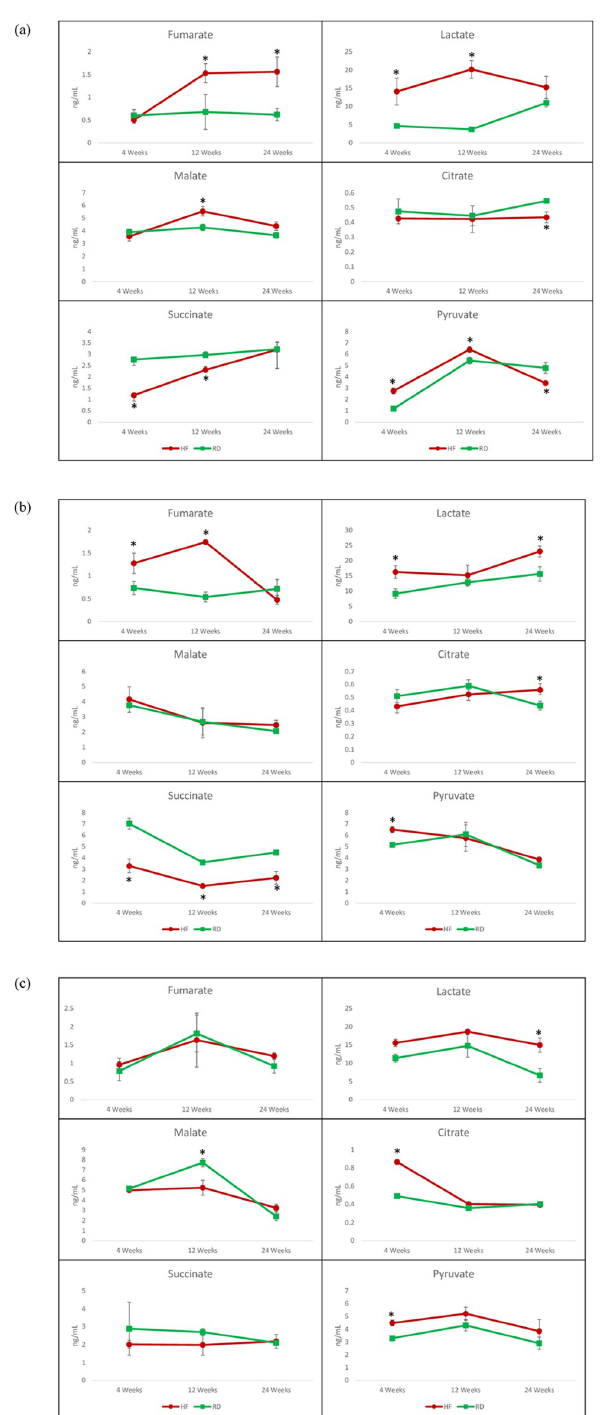
Fig 3. A) Concentrations of liver tricarboxylic acid cycle intermediates for the Brown Norway Strain high fat diet (HF) and regular diet (RD). B) Concentrations of liver tricarboxylic acid cycle intermediates for the Fischer 344 high fat diet (HF) and regular diet (RD). C) Concentrations of liver tricarboxylic acid cycle intermediates for the Sprague Dawley Strain high fat diet (HF) and regular diet (RD). � p = < 0.05.